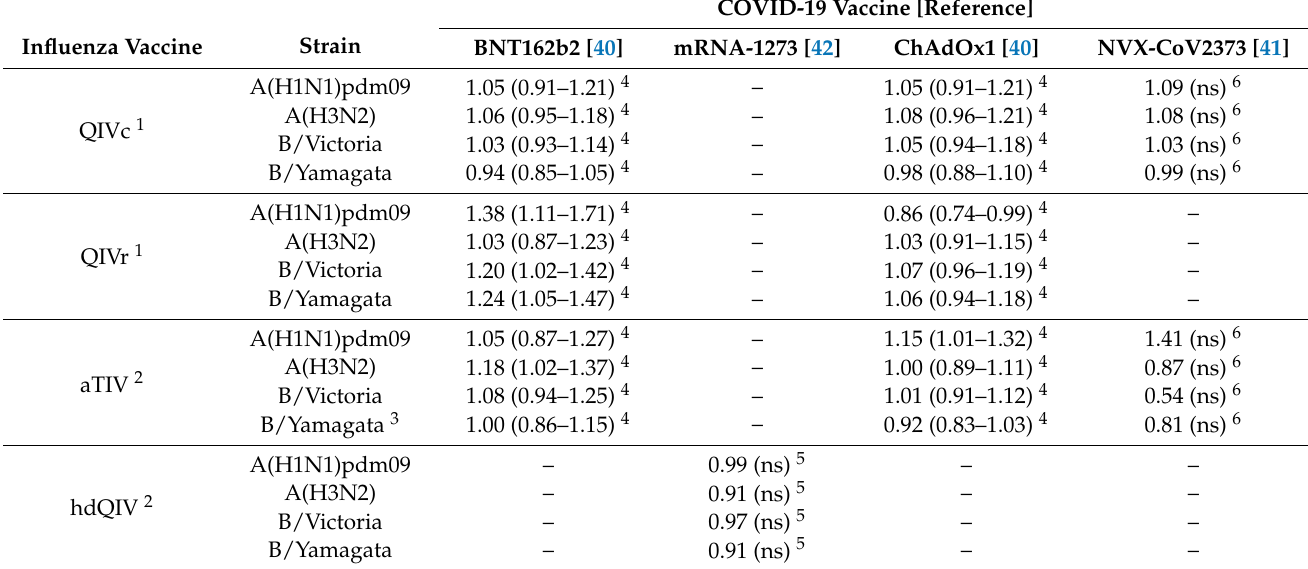
Table 2. Hemagglutination inhibition IgG geometric mean ratios against influenza vaccine strains in COVID-19 + seasonal influenza vaccine co-administration groups, as compared with groups to whom either vaccine was administered